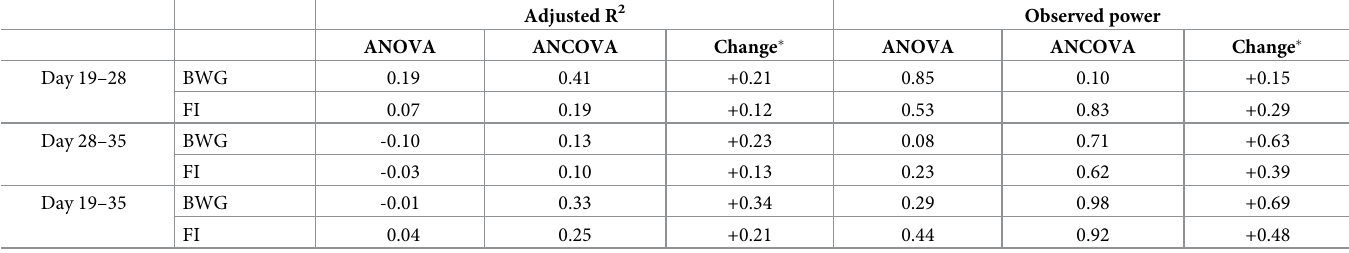
Table 12. Adjusted R 2 and observed power of performance data when analysed by a one-way ANOVA and ANCOVA during different phases for Experiment 4.